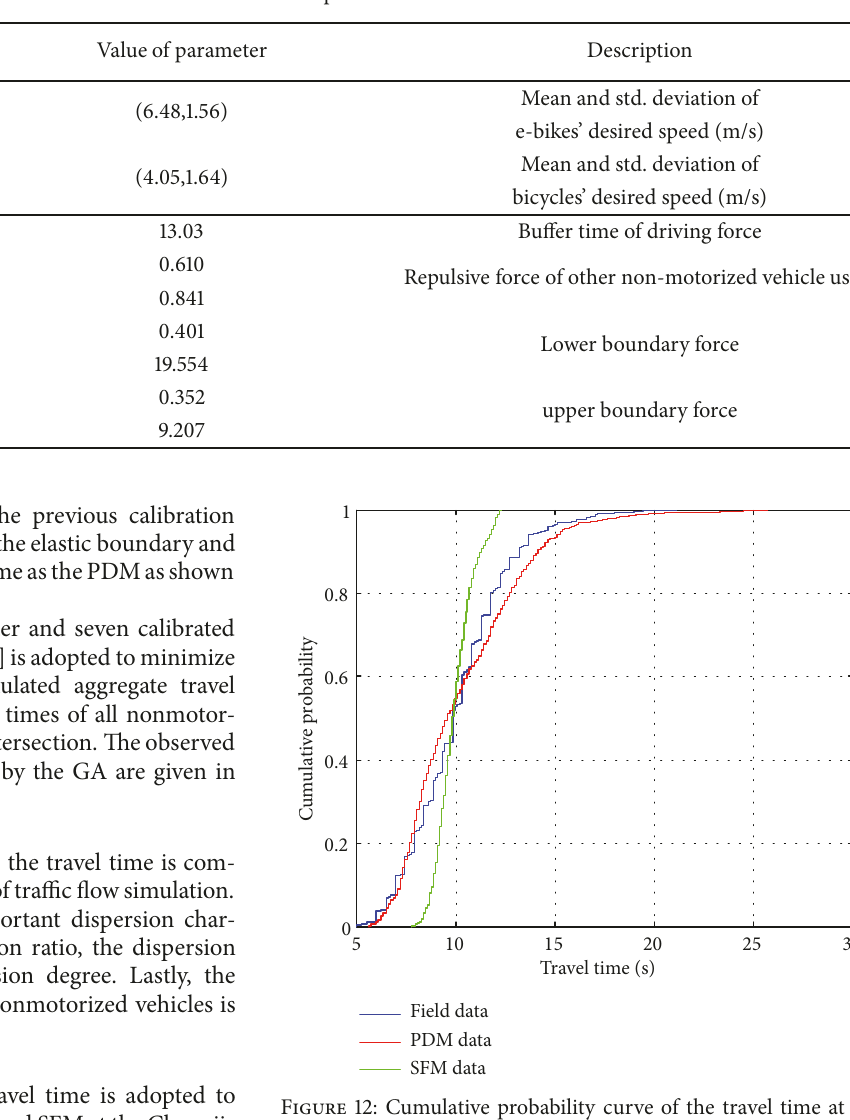
Table 5: Observed and calibrated parameters of SFM.